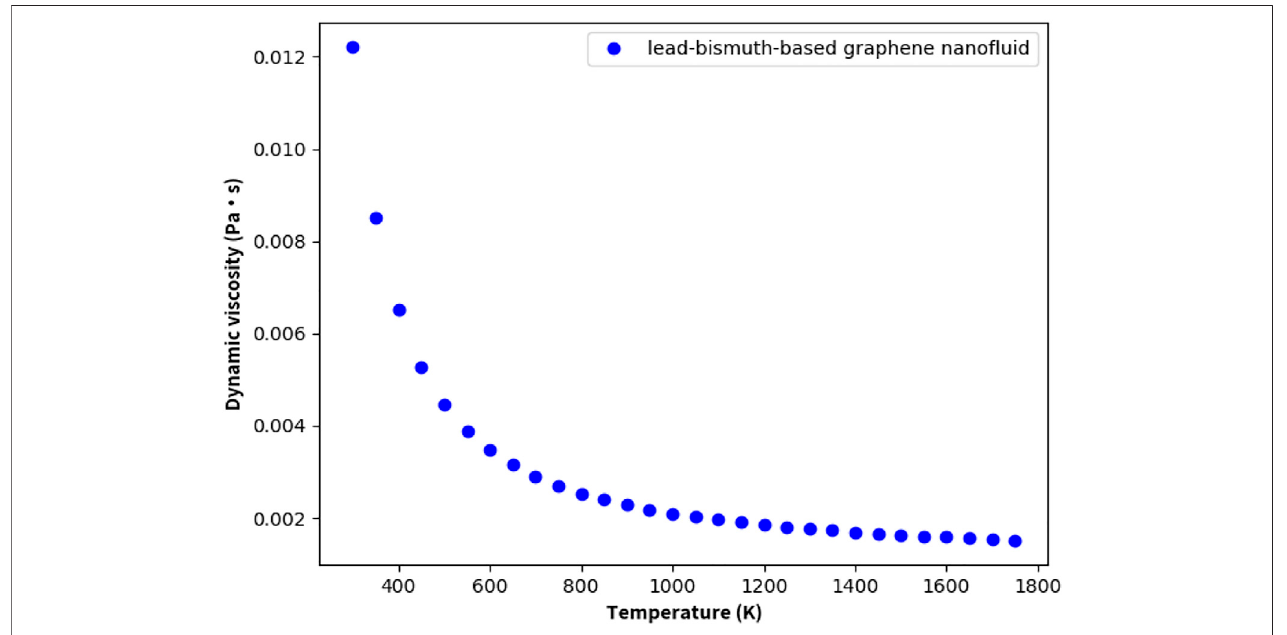
FIGURE 8 | Dynamic viscosity of nano fl uids versus temperature ( φ (cid:2) 0.2).